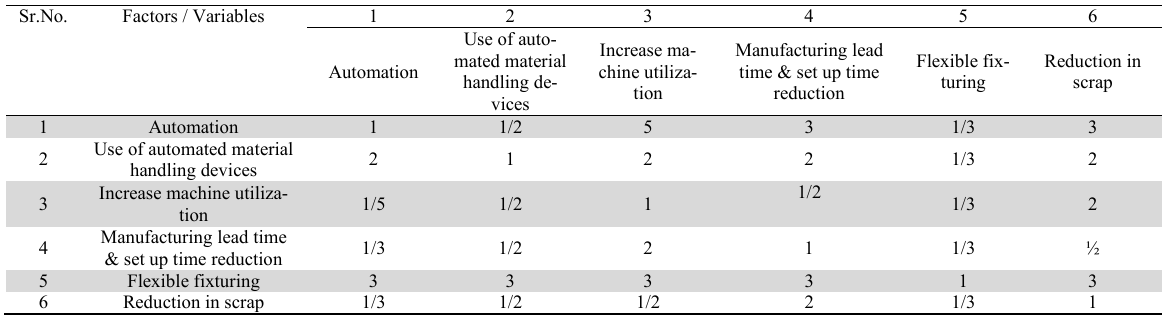
Pairwise matrix